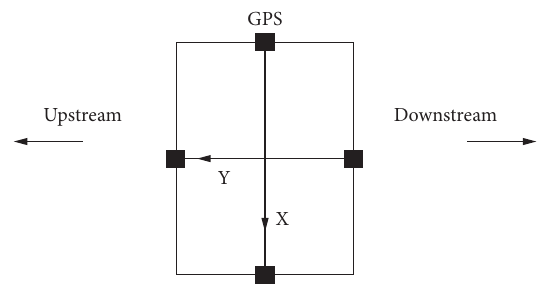
Figure 5: The plane position of monitoring gauges.